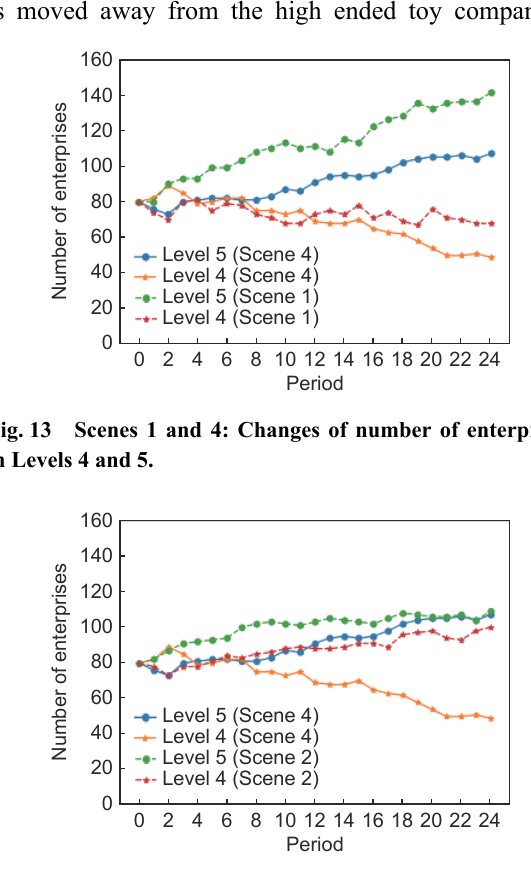
Fig. 14 Scenes 2 and 4: Changes of number of enterprises in Levels 4 and 5.